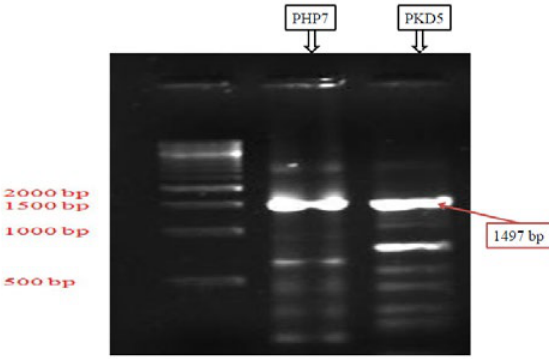
Fig. 3: Laccase gene amplification from PHP7 and PKD5 isolates DNA Fig. 3. Laccase gene amplification from PHP7 and PKD5 isolates